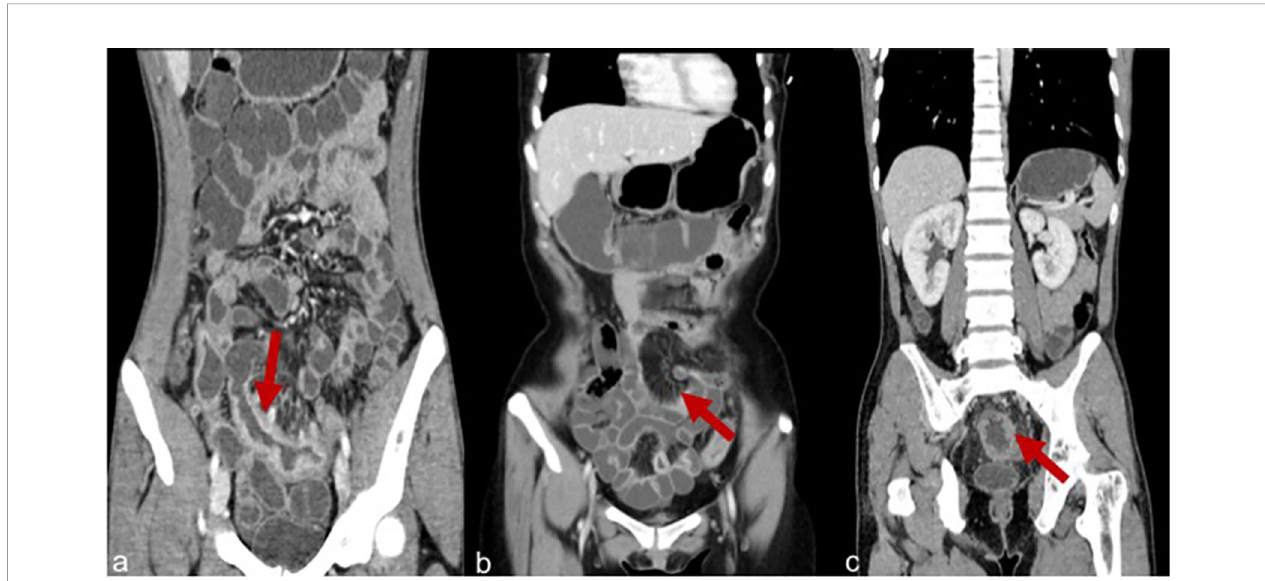
FIGURE 2 | (A) Severe enhancement in a patient with CD. (B) Engorged vasa recta in a patient with CD. (C) Homogeneous enhancement in a patient with